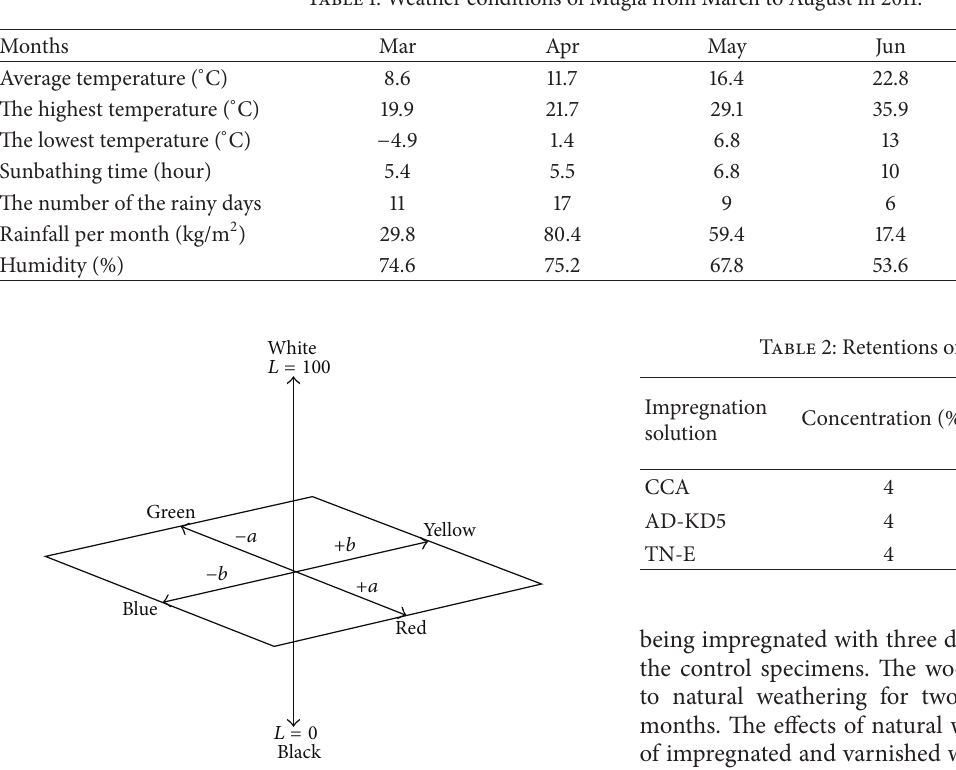
Table 1: Weather conditions of Mugla from March to August in 2011.